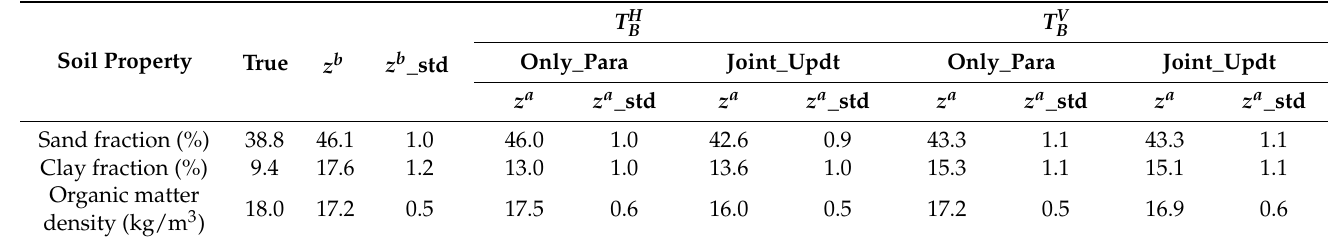
soil layer sampled in the field. The top panel labeled ( a ) displays the Only_Para experiment results based on SMAP T H assimilation. The bottom panel ( b ) displays the Joint_Updt experiment results. In B each subfigure, gray indicates the prior, light blue indicates the posterior, and the black dash-dotted line indicates the laboratory measurements. Table 4. Data assimilation results and their calculated standard deviations (_std) for the retrieved soil properties of the first layer. z b and z a denote background and analysis, respectively.